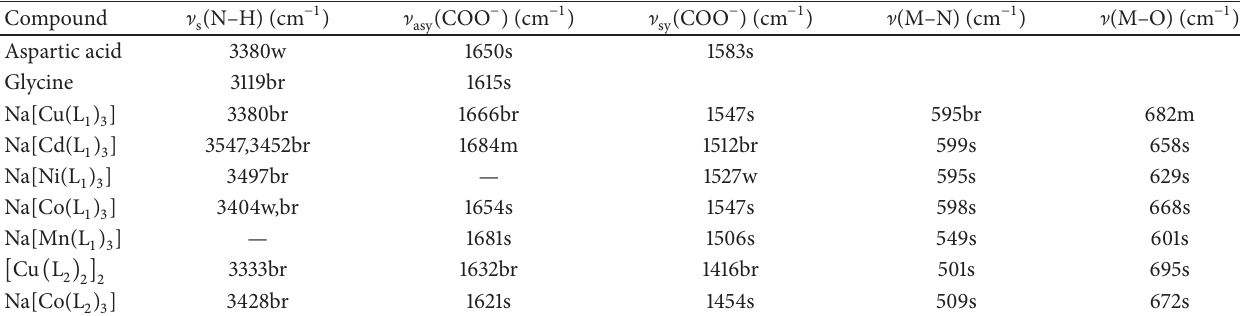
Table 1: Relevant IR bands for the ligands and